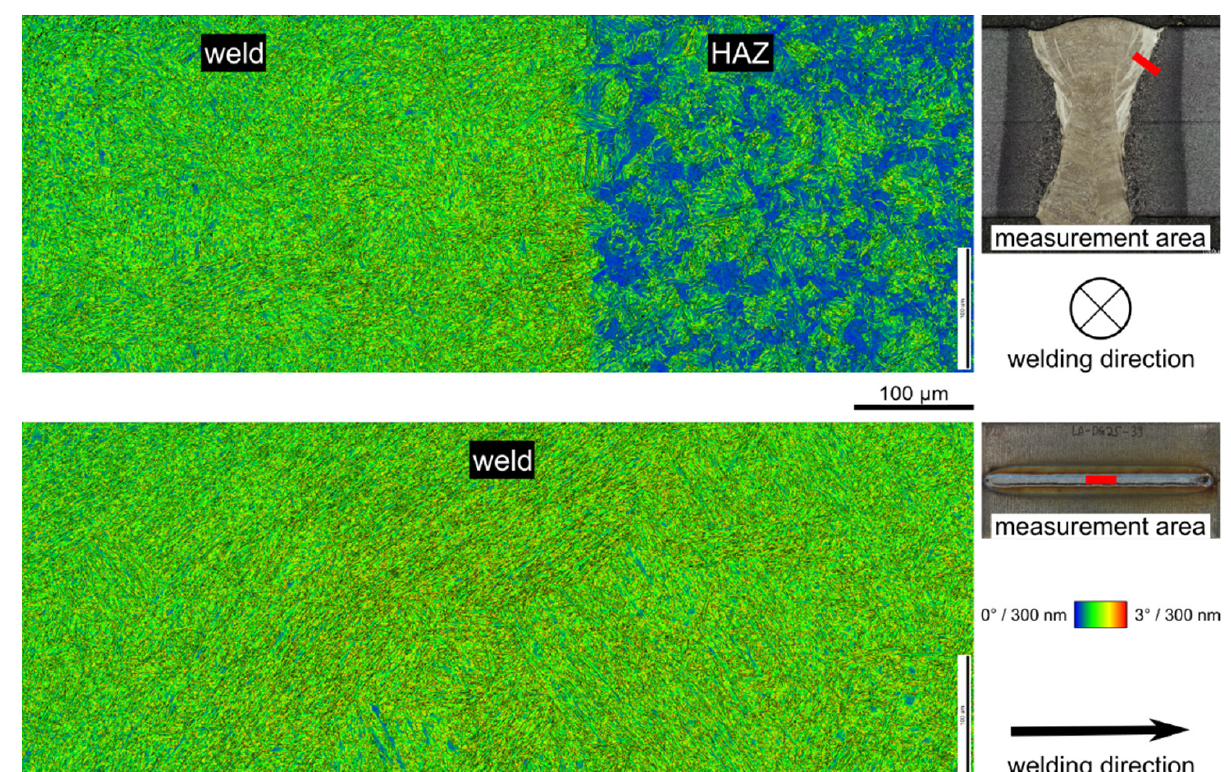
Figure 13. Kernel average misorientation (KAM) maps, calculated for point distances of 300 nm. Besides the phase content of the weld, the EBSD measurements generally could also indicate the occurrence of preferred crystal orientations within the weld. In Figure 14, therefore, inverse pole figure (IPF) maps are plotted, showing the crystal direction locally aligned with the welding direction. Since during the martensitic transformations only martensite plates with a limited number of orientations can form, clusters of the same sets of colors indicate the extension of the austenite grains present before the martensitic transformation. As can be seen, these prior austenite grains extend over several 100 µ m, which makes it difficult to reliably detect preferred orientations in the complete weld. In contrast to the high number of fine martensite plates, only a small number of prior austenite grains are covered by the measurement areas, the orientations of which will determine the martensite orientations present. In conclusion, locally preferred orientations exist determined by the orientation of the prior austenite grain. Therefore, if globally preferred orientations exist over larger areas of the weld, this cannot be decided by